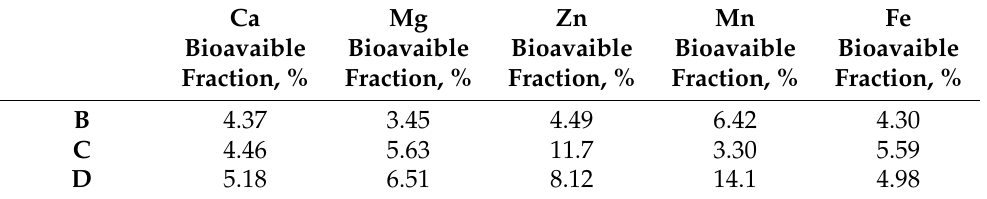
Table 7. Bioavailable concentrations of Ca, Mg, Zn, Mn, and Fe as a percentage of total content. Ca